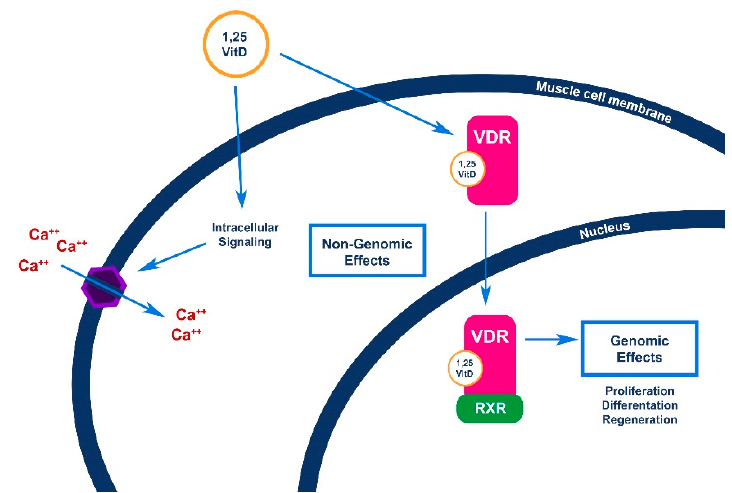
Figure 4. Brief overview of the genomic and non-genomic pathways of vitamin D at muscle cellular level. Vitamin D regulates gene expression in the nucleus by interacting with VDR, thus forming a heterodimeric complex of liganded VDR with RXR and upregulating or downregulating target genes transcription. The non-genomic effects of Vitamin D are mediated by the activation of several intracellular signal pathways through signal molecules, e.g., phospholipase C and phospholipase A2, and the production of second messengers, protein kinases, and the opening of Ca 2+ and Cl − channels. Abbreviations: VDR: Vitamin D Receptor; RXR: Retinoid-X-receptor; 1,25VitD: 1,25-hydroxyvitamin D.